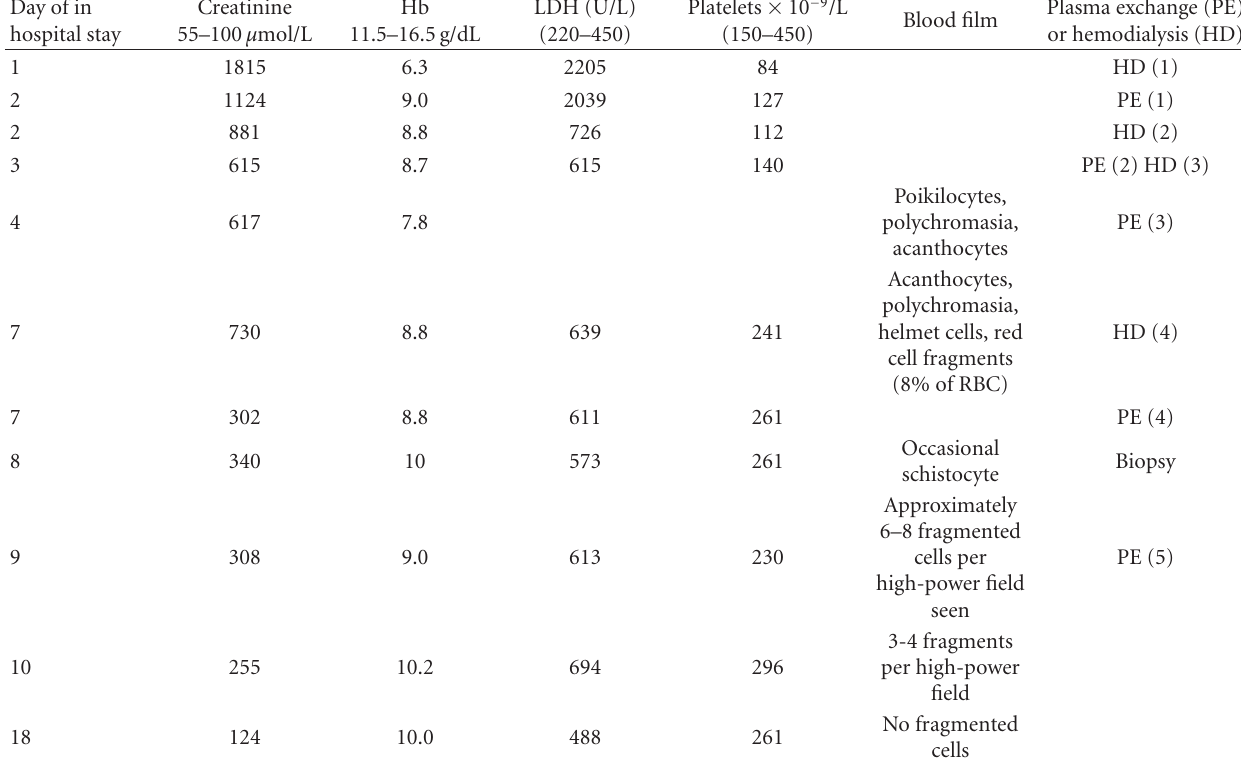
Table 1: Biochemical and hematological parameters during admission.